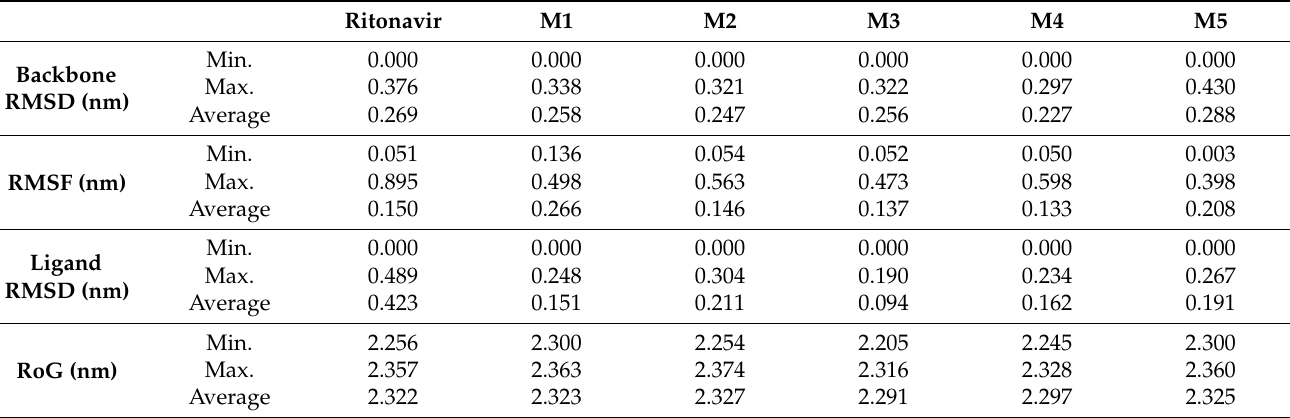
Table 4. Statistical parameters of CYP3A5 molecules obtained from MD simulation trajectories.